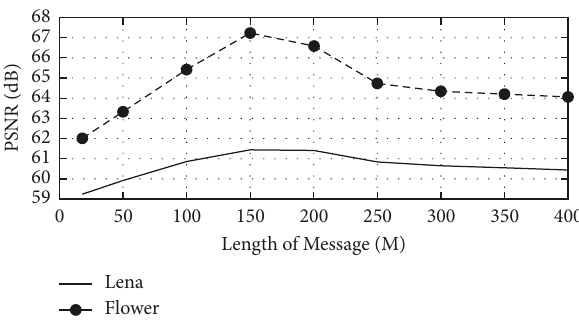
Figure 12: Variation of the PSNR of Lena and flower versus the length of message M